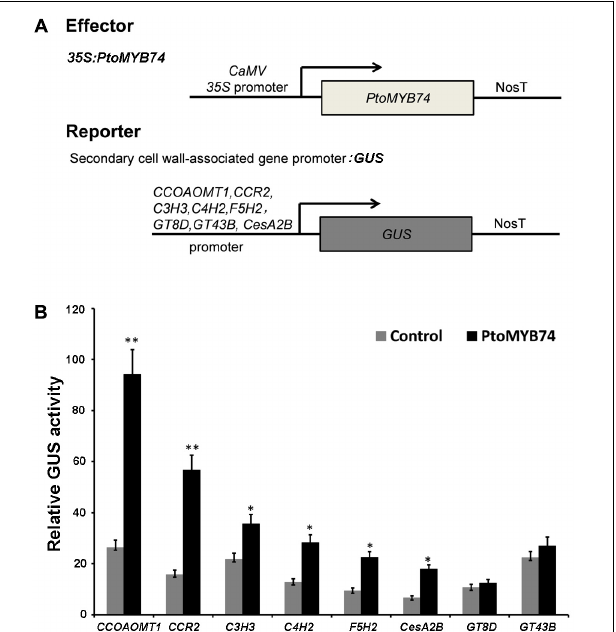
FIGURE 8 | Activation of the promoters of some secondary cell wall biosynthetic genes by PtoMYB74 . (A) Diagrams of the effector and reporter constructs used for transactivation analysis. The effector construct is the PtoMYB74 cDNA driven by the 35S promoter. The reporter constructs contain the GUS reporter genes driven by the promoters of some secondary cell wall biosynthetic genes, including CCOAOMT1 , CCR2 , C3H3 , C4H2 , F5H2 , GT8D , GT43B, and CesA2B . (B) Transactivation analysis shows that PtoMYB74 activated individually the CCOAOMT1/CCR2/C3H3/C4H2/F5H2/ CesA2B promoter-driven expression of the GUS reporter gene. GUS activity in leaves transfected with the reporter gene alone was used as a control. Error bars represent ± SD of three biological replicates. Student’s t -test: ∗ P < 0.05; ∗∗ P <